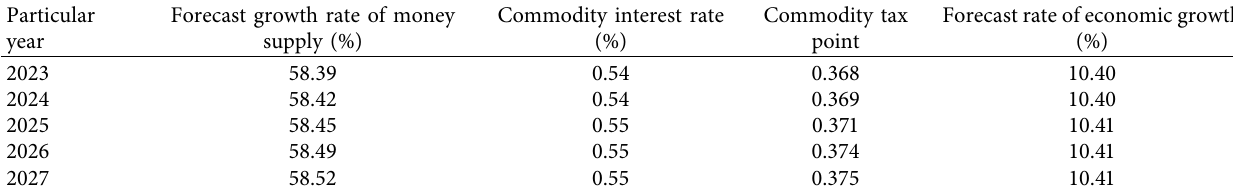
Table 6: Prediction results.